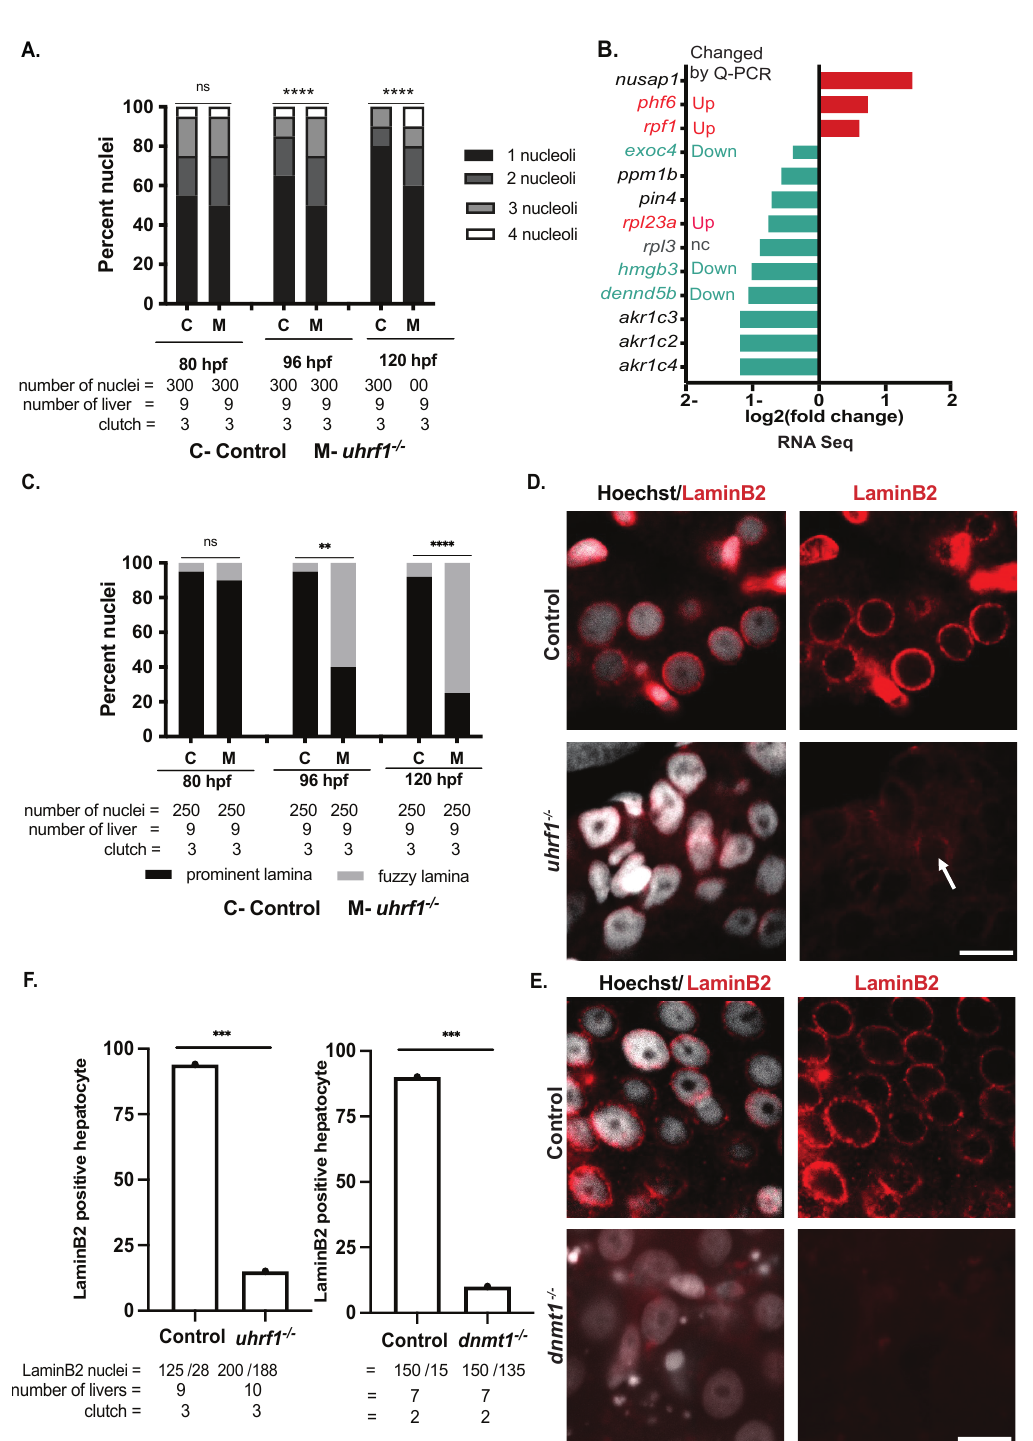
Figure 6. uhrf1 loss disrupts hepatocyte nucleoli and laminB2 organization. ( A ). Control and uhrf1 − / − hepatocyte nuclei scored at 80, 96, and 120 hpf for the number of nucleoli per hepatocyte. ( B ). Differential expression of nucleoli-associated genes in 120 hpf uhrf1 − / − livers, nc: not significantly changed ( C ). Control and uhrf1 − / − hepatocyte nuclei scored at 80, 96, and 120 hpf for the presence of normal lamina. ( D , E ). Confocal images comparing the immunostaining of LaminB2 in 120 hpf uhrf1 − / − and dnmt1 − / − livers with their respective WT controls. ( F ). Quantitative changes in LaminB2 staining in 120 hpf uhrf1 − / − and dnmt1 − / − hepatocyte nuclei. The numbers of LaminB2 positive nuclei are indicated below each bar. White arrows mark LaminB2 positive hepatocyte nuclei. All analyses were performed on 2 or 3 clutches, with minimum 3 livers analyzed per clutch. ** p < 0.005, *** p < 0.0005, **** p < 0.00005. Magnification: 63 × , Scale bar: 7 µ